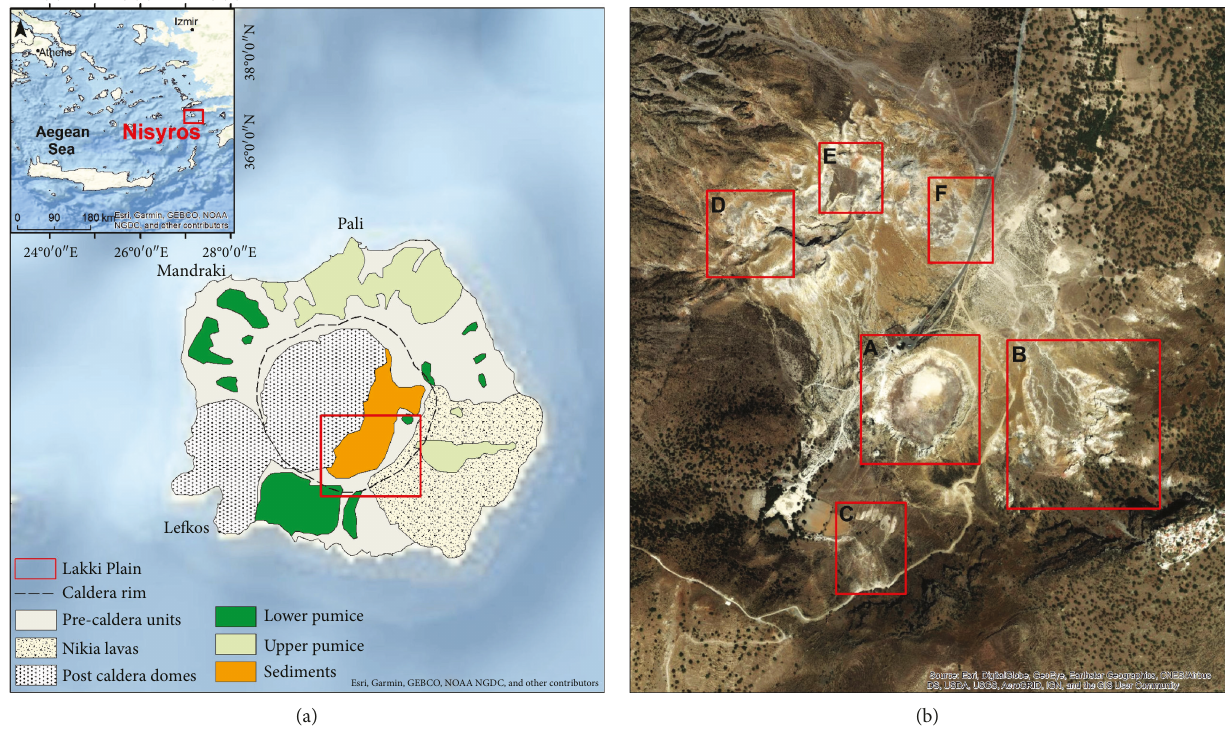
Figure 1: Simpli fi ed geologic map of the island of Nisyros (a) and sampling areas within the Lakki Plain (b). A=Stefanos crater; B=Kaminakia crater; C =Ramos fumaroles; D=Phlegeton crater; E =Mikros Polybotes; F=Lofos